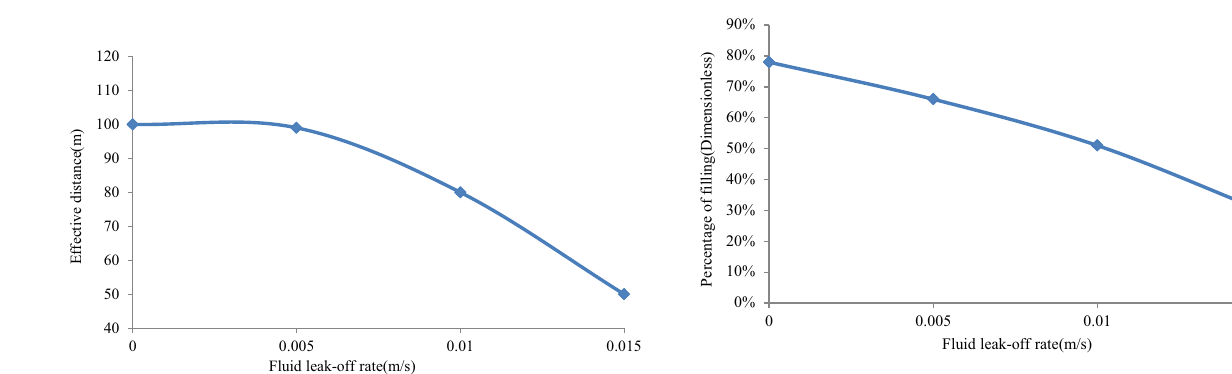
Fig. 6 Effective distances at different fluid leak-off rates